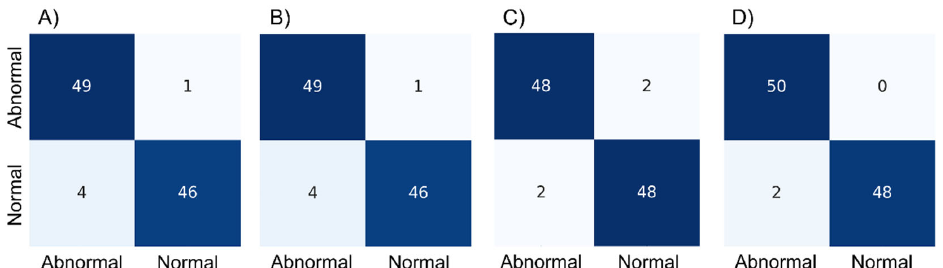
Figure 2. Confusion matrix in the ( A ) ResNet ‐ 152, ( B ) DenseNet ‐ 201, ( C ) EfficientNet ‐ B7, and ( D ) ensemble models. The horizontal and vertical labels indicate the prediction by each model and ground truth, respectively. ( A ) ResNet ‐ 152 showed an accuracy of 95% (abnormal 49/50, normal 46/50). ( B ) DenseNet ‐ 201 showed an accuracy of 95% (abnormal 49/50, normal 46/50). ( C ) EfficientNet ‐ B7 showed an accuracy of 96% (abnormal 48/50, normal 48/50). ( D ) The ensemble model showed an accuracy of 99% (abnormal 50/50, normal 48/50).